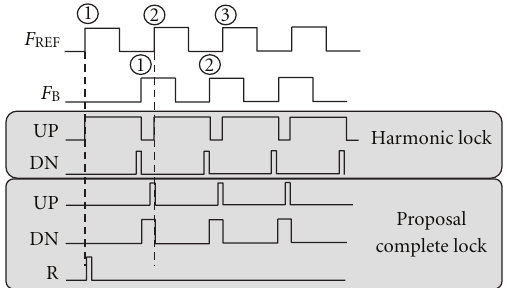
Figure 7: Explanation of harmonic lock and proposed shot pulse reset operation.